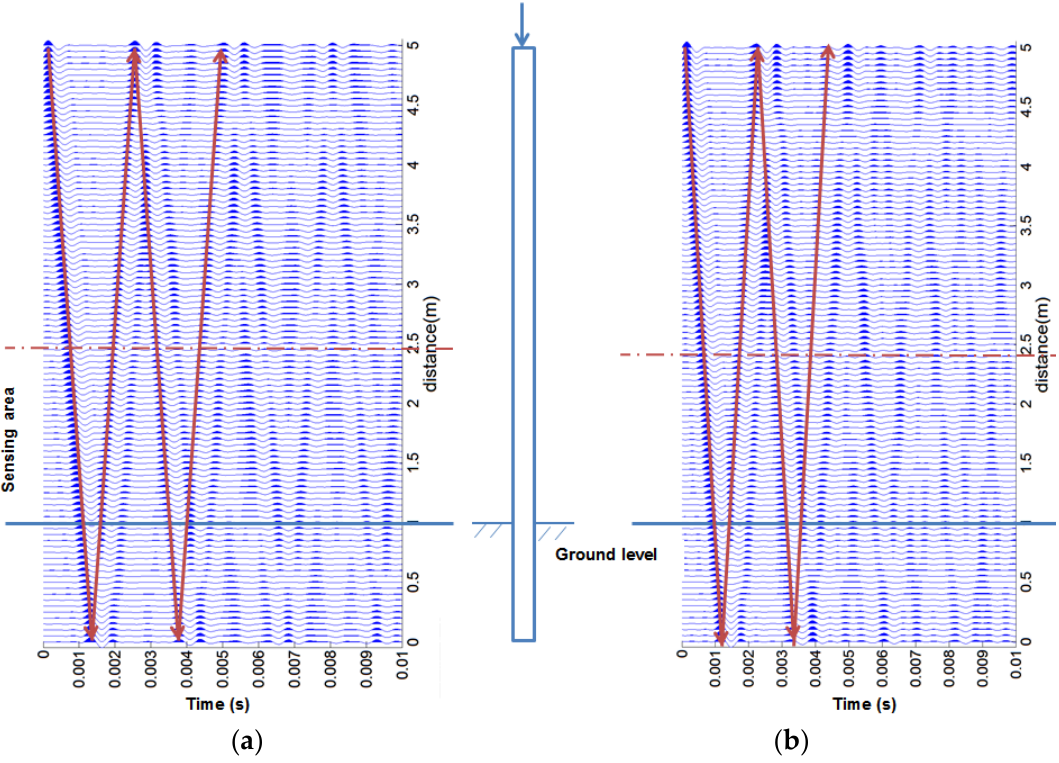
Figure 20. Wave trace of a 5 m pole for top excitation with ( a ) isotropic and ( b ) orthotropic material models.